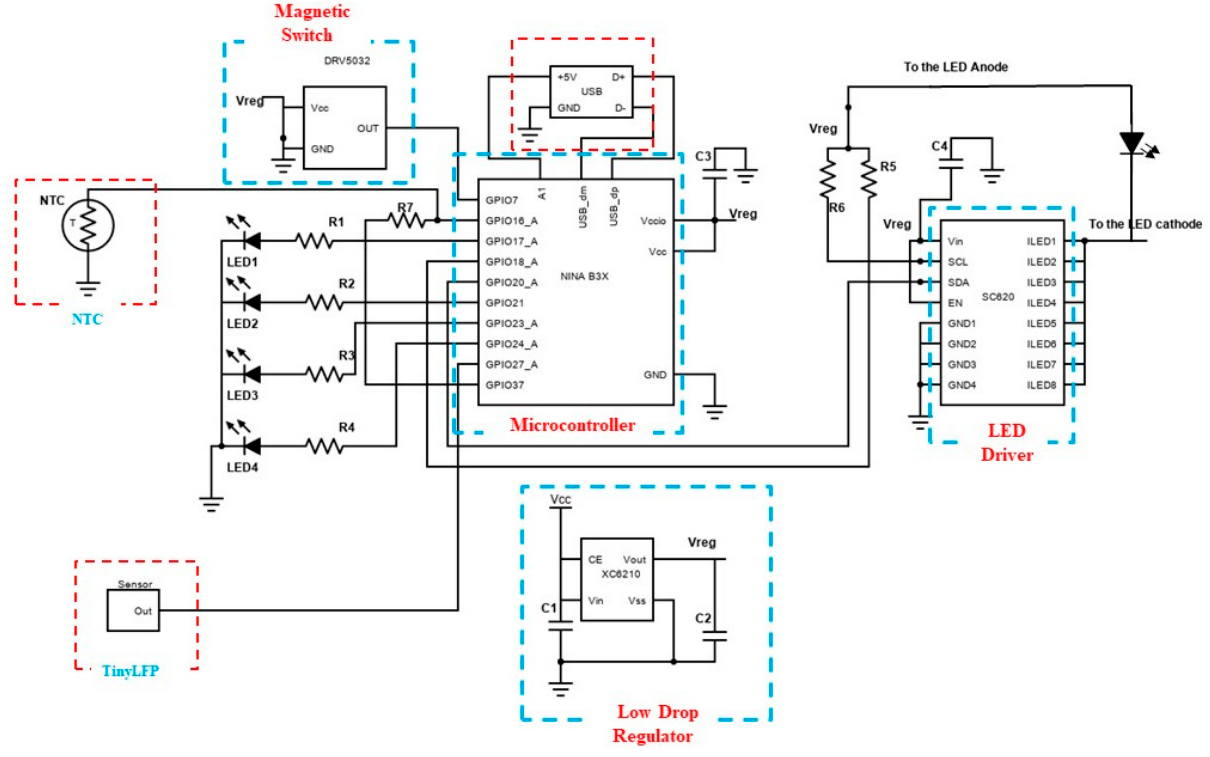
Figure 4. Circuit diagram of the optogenetic stimulator.